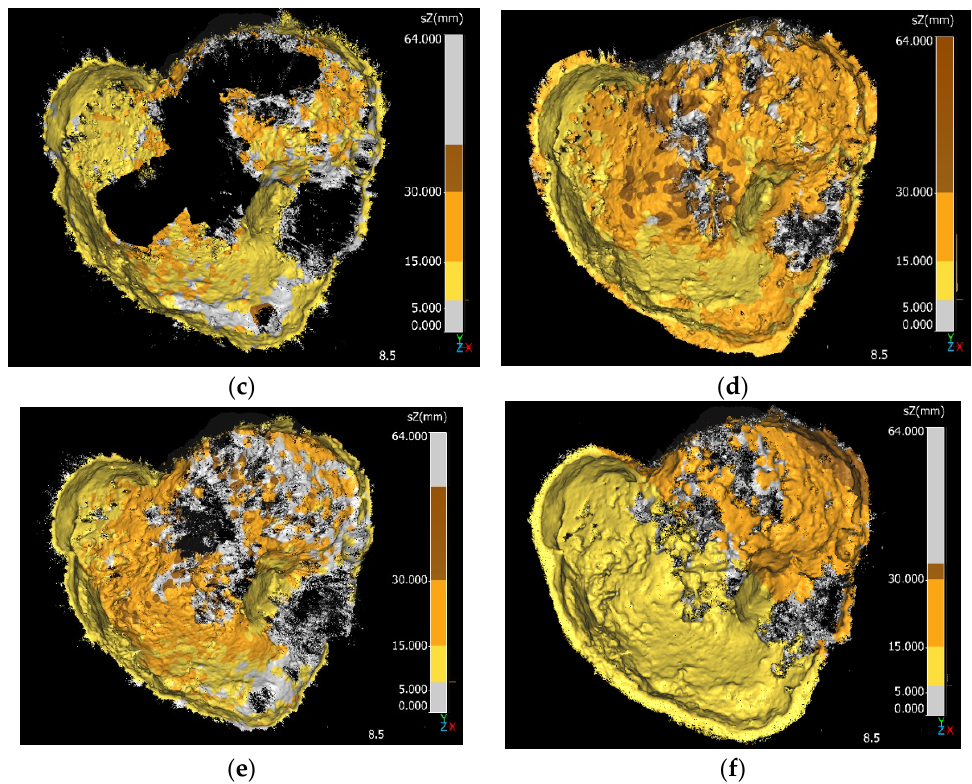
Figure A2. ( a ) 2017 point cloud from terrestrial imagery, ( b ) 2017 point cloud from aerial imagery, ( c ) 2018 point cloud from terrestrial imagery, ( d ) 2018 point cloud from aerial imagery, ( e ) 2019 point cloud from terrestrial imagery and ( f ) 2019 point cloud from aerial imagery. ( a – e ): Input PNG pictures of the point clouds; view from the top. Note the considerable amount of black pixel around the sinkhole. As this is assumed to be roughly the same size for all point clouds, assessing the percentage of black pixel is assumed to be a good measure of the different sizes of holes in the point clouds. As scalar field we decided to visualize the vertical point precision estimates as in Figure 2 as well.